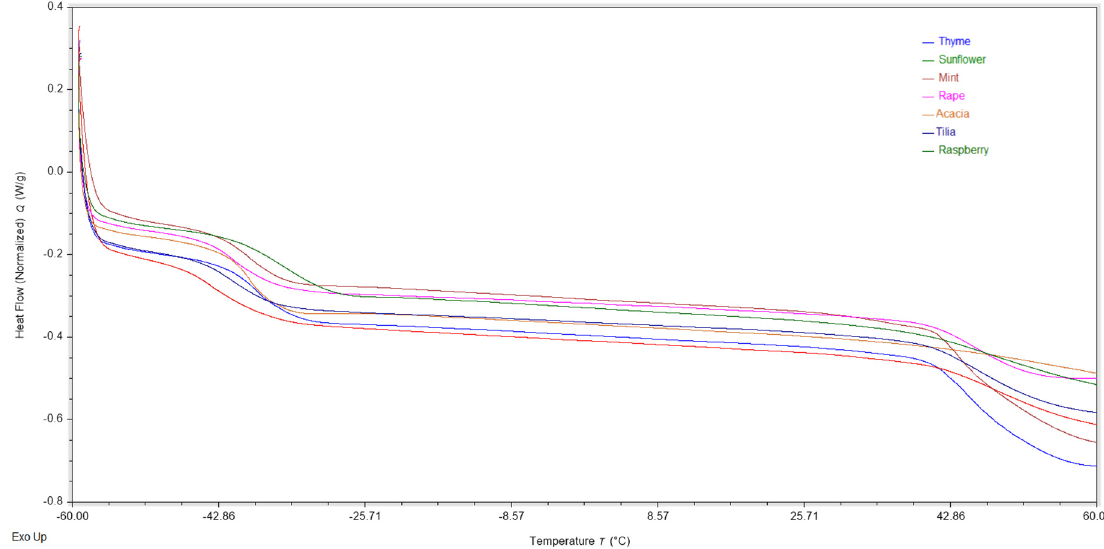
Figure 3. Typical thermograms for thyme, sunflower, mint, rape, acacia, tilia and raspberry honey samples, showing glass transition temperatures.